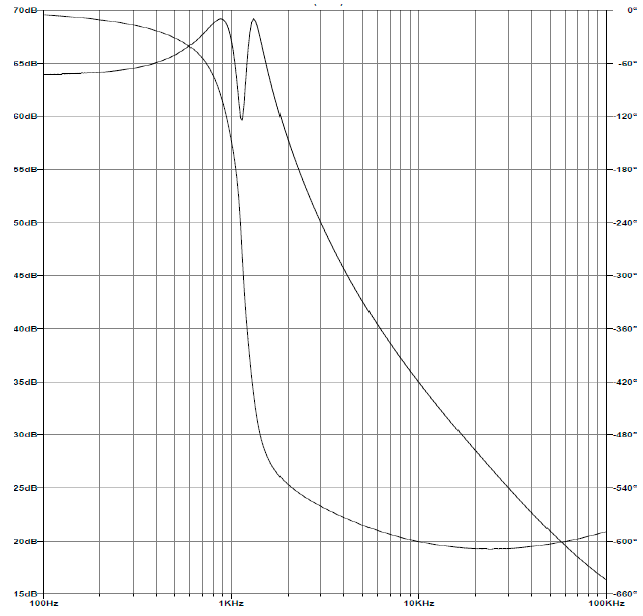
Figure 14. G vd for SEPIC for fixed R.